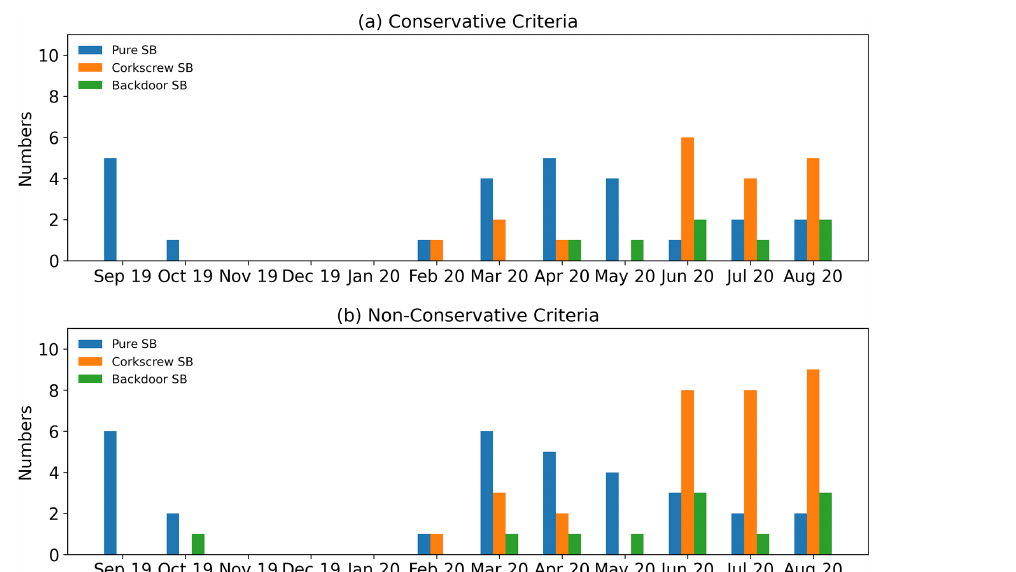
Figure 10. Monthly time series of identified sea breeze events from September 2019 (Sep 19) to August 2020 (Aug 20) using the conservative criteria (a) and non-conservative criteria (b) for the pure sea breezes (blue), the corkscrew sea breezes (orange) and the backdoor sea breezes